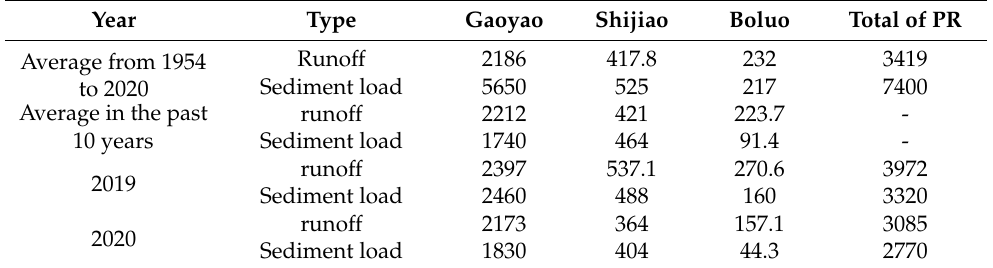
Table 1. Basic information on runoff (10 8 m 3 ) and sediment load (10 4 t) of the Pearl